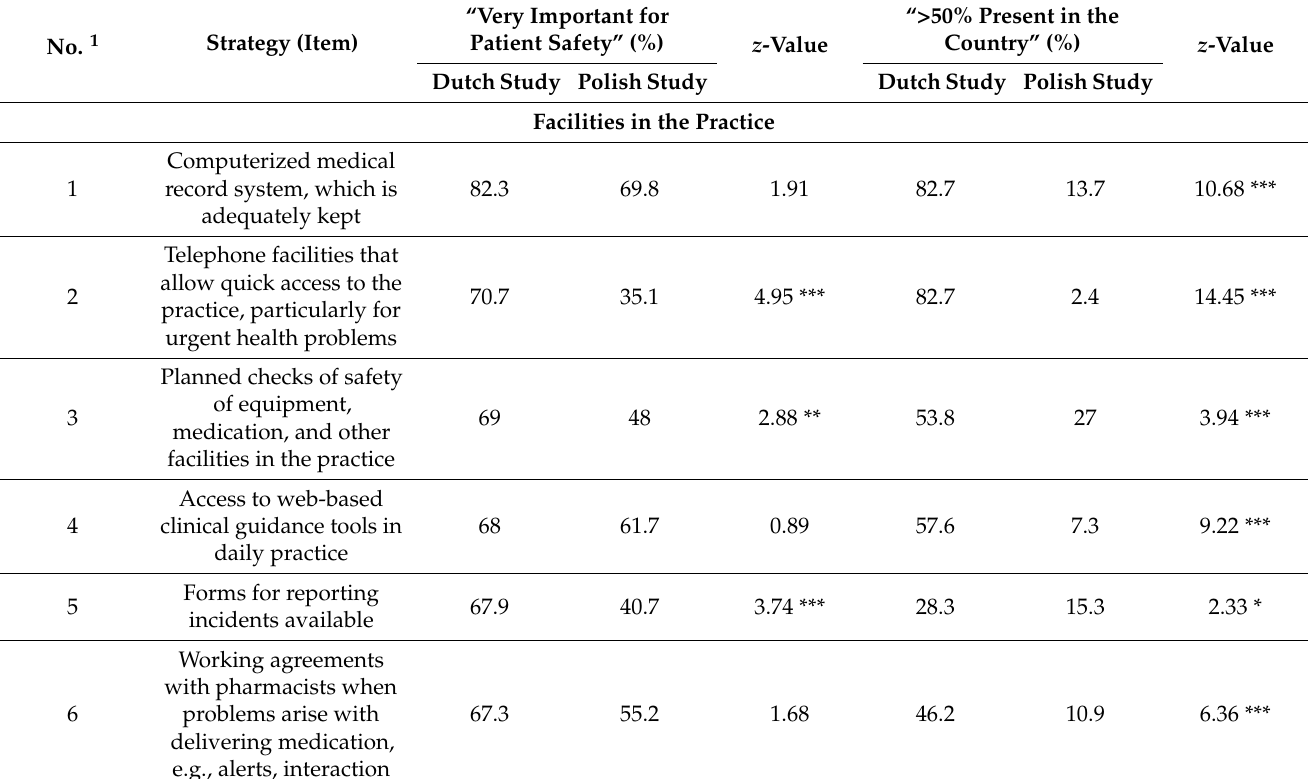
Table 1. Views on the importance and implementation of patient safety interventions. GP, general practitioner.